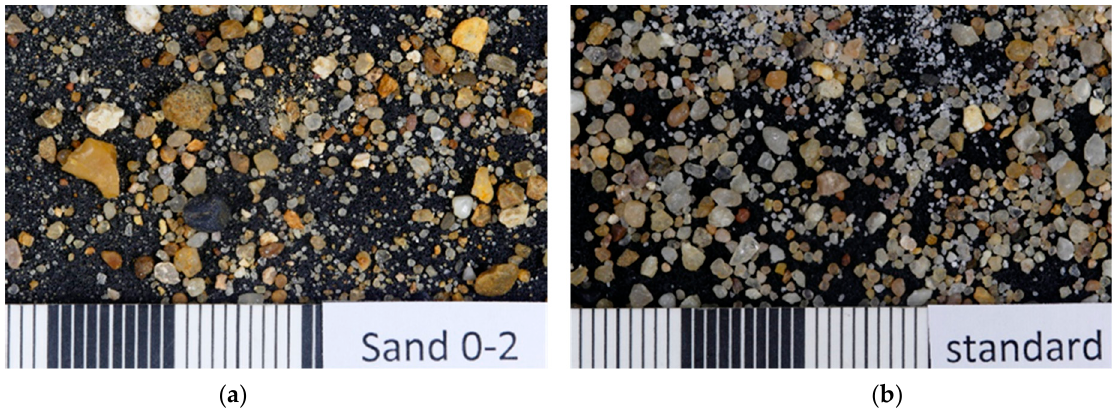
Figure 2. ( a ) Sand (0–2 mm) used for the mixture with 4, 8 and 16 mm maximum aggregate size, ( b ) Standard sand according to DIN EN 196 used for the mixture with 2 mm maximum aggregate size (R2-0.5-OPC and R2-0.6-OPC).